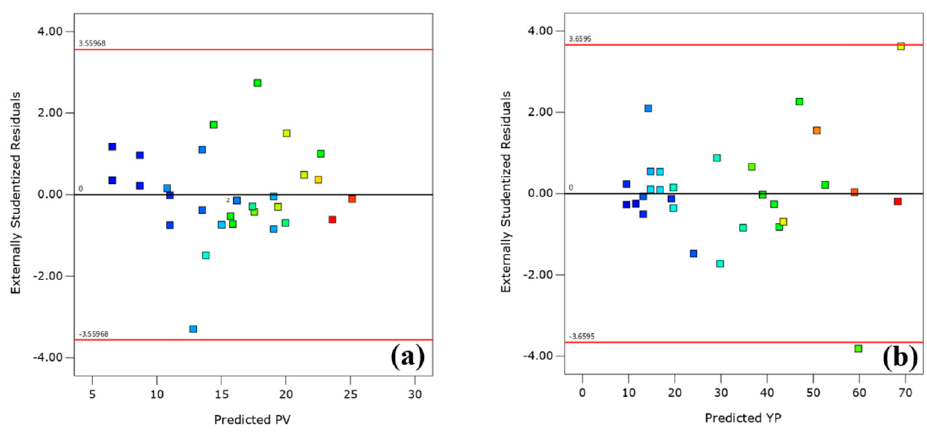
Figure 8. Plot of the residuals vs. predicted responses of ( a ) PV and ( b ) YP.